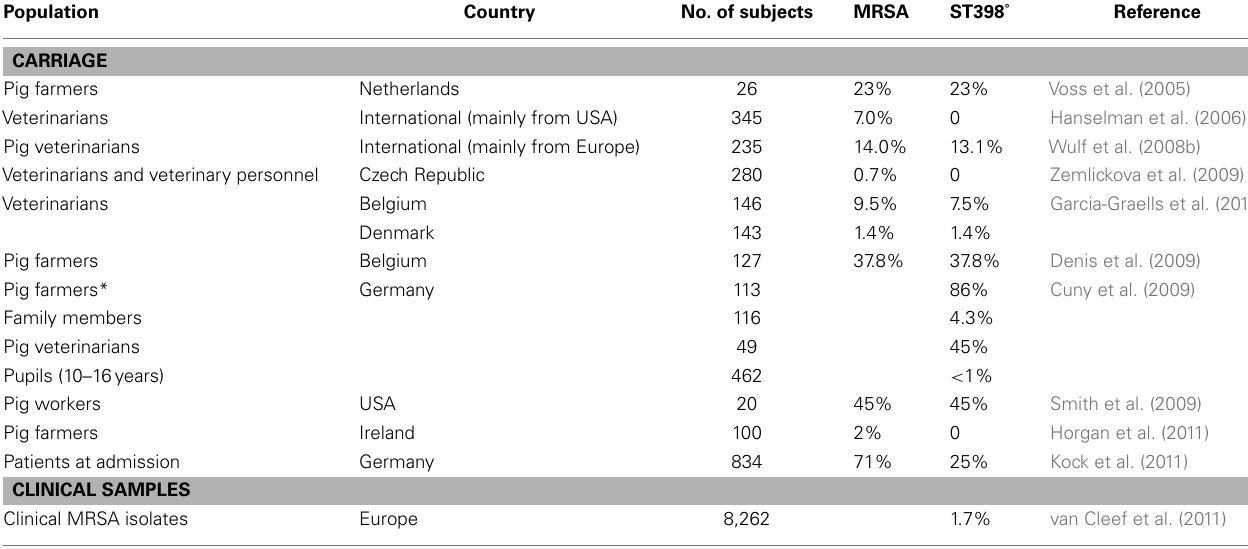
Table 3 | Prevalence of MRSA and ST398 MRSA carriage in different healthy populations, in patients, and among clinical isolates.